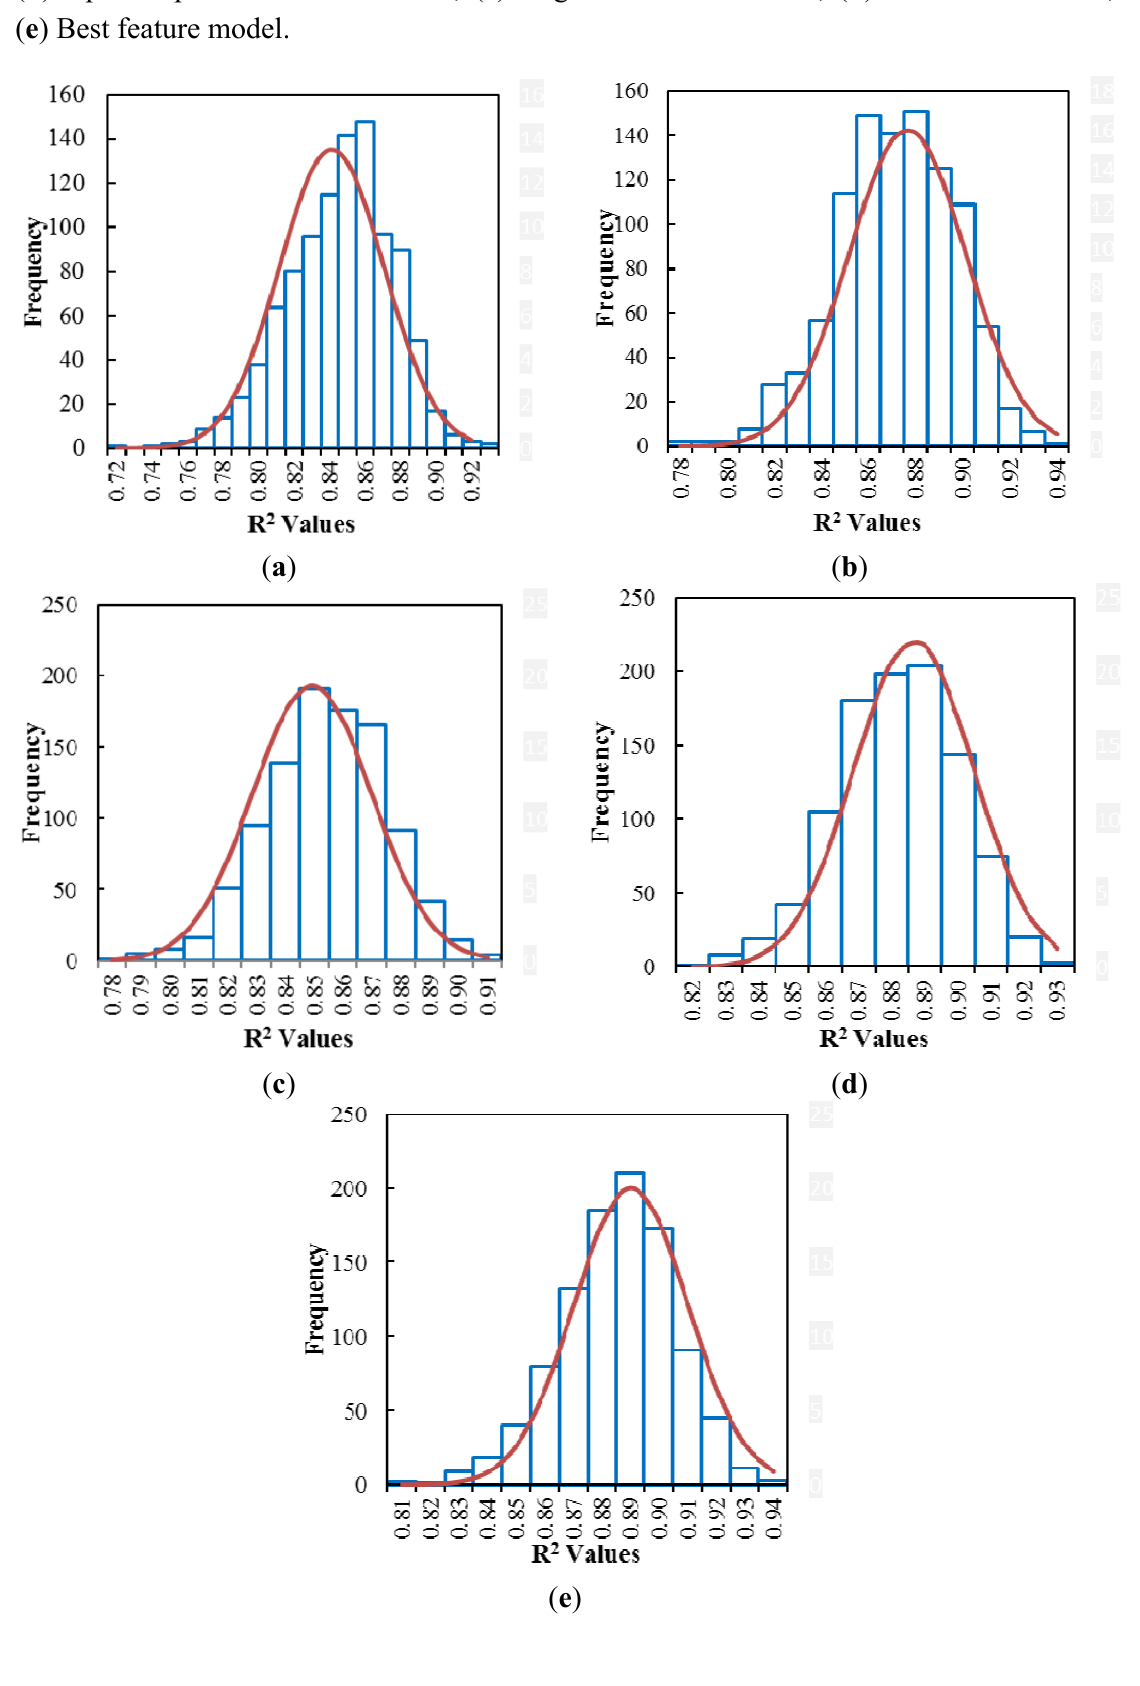
Figure 5. Histograms showing the frequency of R 2 values between the measured and predicted LAI for the independent dataset. ( a ) Optimal waveband feature model, ( b ) Optimal position feature model, ( c ) Vegetation Index model, ( d ) All feature model, ( e ) Best feature